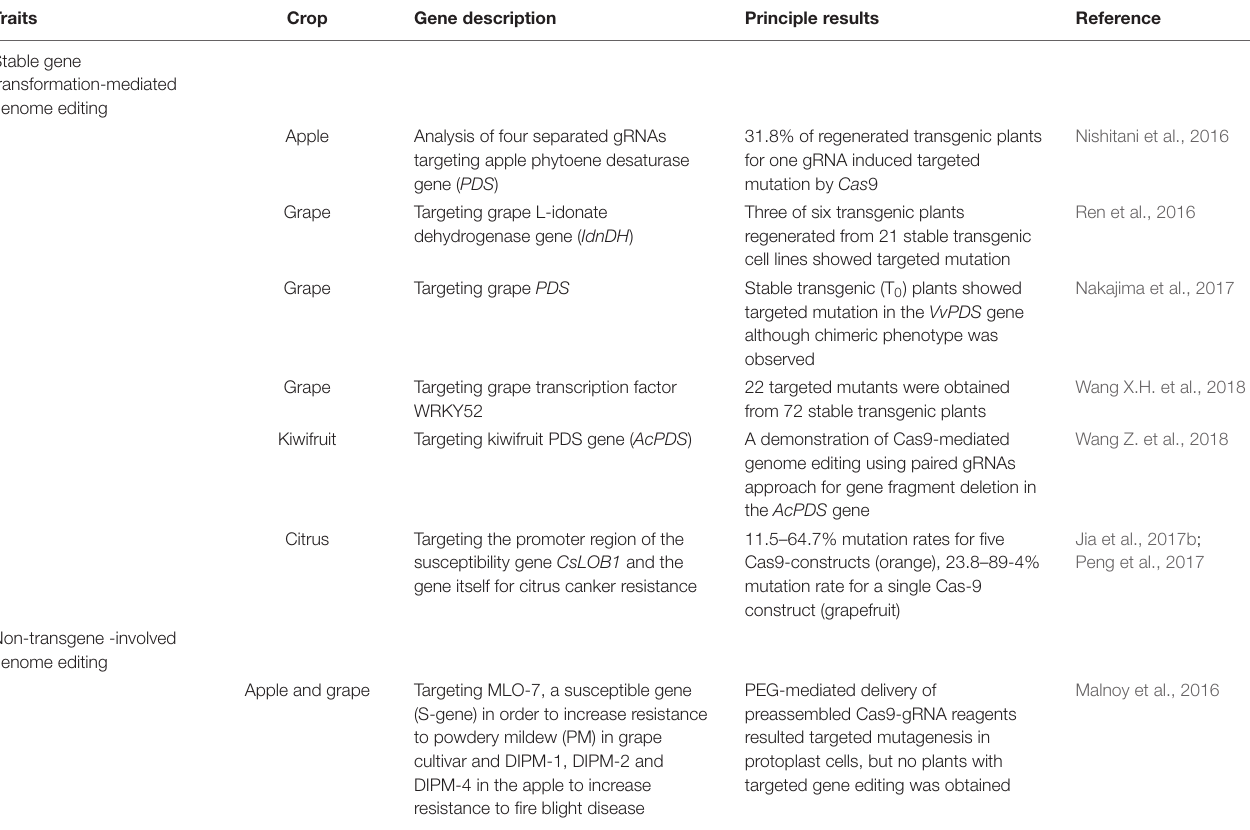
TABLE 2 | Application of CRISPR-Cas9 gene editing technologies for F&N crops. Traits Crop Gene